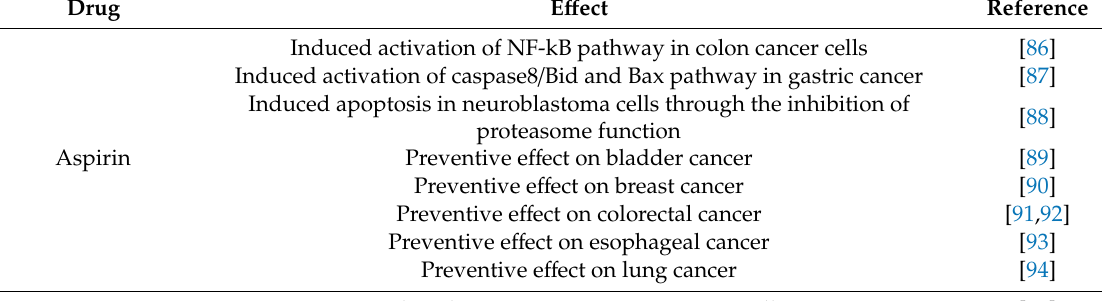
Table 1. Preventive and anticancer e ff ects of anti-inflammatory drugs. Drug E ff ect